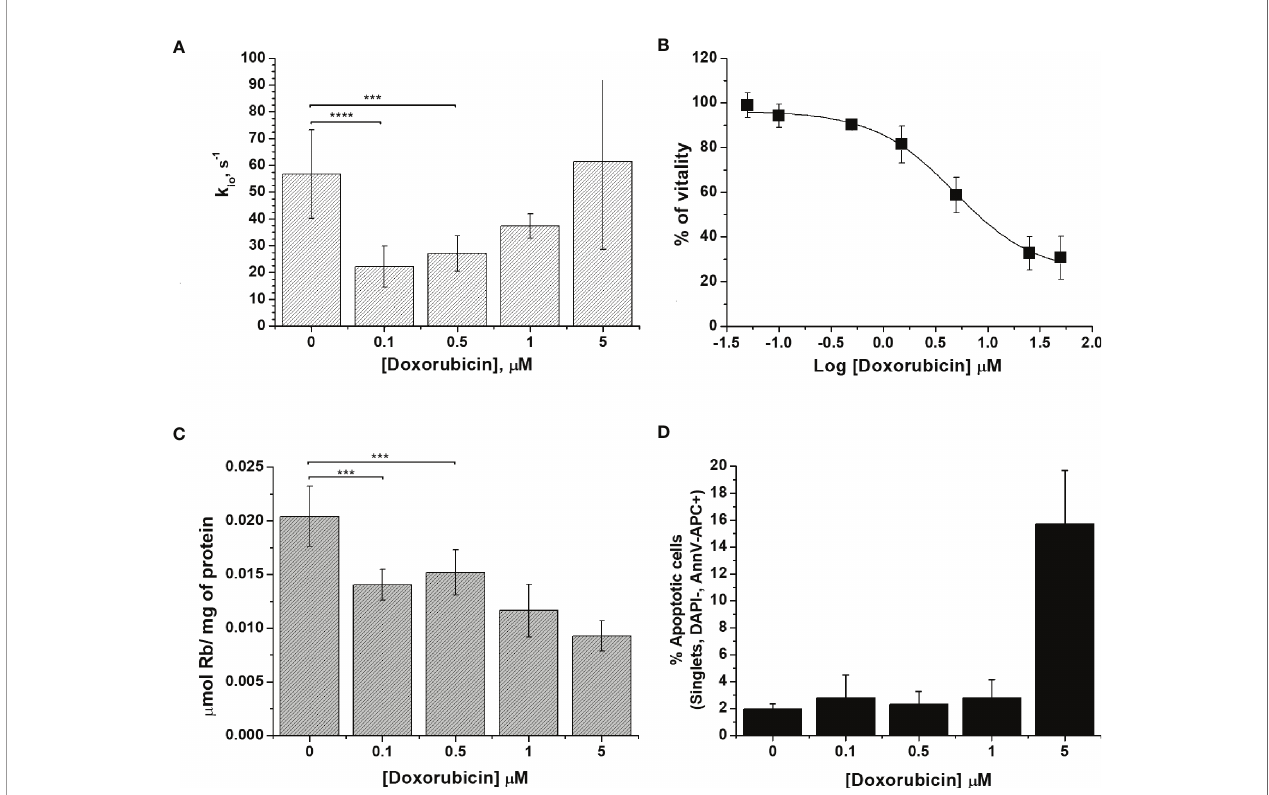
FIGURE 1 | The characterization of 4T1 cells. (A) The cellular water ef fl ux rate constant, k io (s -1 ), as determined 24 h after doxorubicin treatment at different drug concentrations (0.1-5 µM). k io was determined by measuring the water proton relaxation times of cell suspensions in the presence of 10 mM of Gd-HPDO3A at 25°C on a fi xed frequency spectrometer operating at 0.5 T. Data are expressed as the mean ± SD with n ≥ 7. (B) Percentage of viable cells plotted vs. Log[Doxorubicin] after 24 h of treatment, obtained using the MTT test. Data are expressed as the mean ± SD of three independent experiments. (C) Cellular uptake of Rb (µmol of Rb/mg of protein) measured 24 h after doxorubicin treatment. The cells were suspended in a medium containing RbCl 0.12 mM for 1 h at 37°C and 5% of CO 2 . Data are expressed as the mean ± SD of three independent experiments. (D) Determination of the % of apoptotic cells after doxorubicin treatment at different concentrations. The percentage of apoptotic cells was assessed using DAPI-, AnnV-APC+ staining with FACS analysis. Data are expressed as the mean ± SD of three independent experiments. (***p ≤ 0.001, ****p ≤